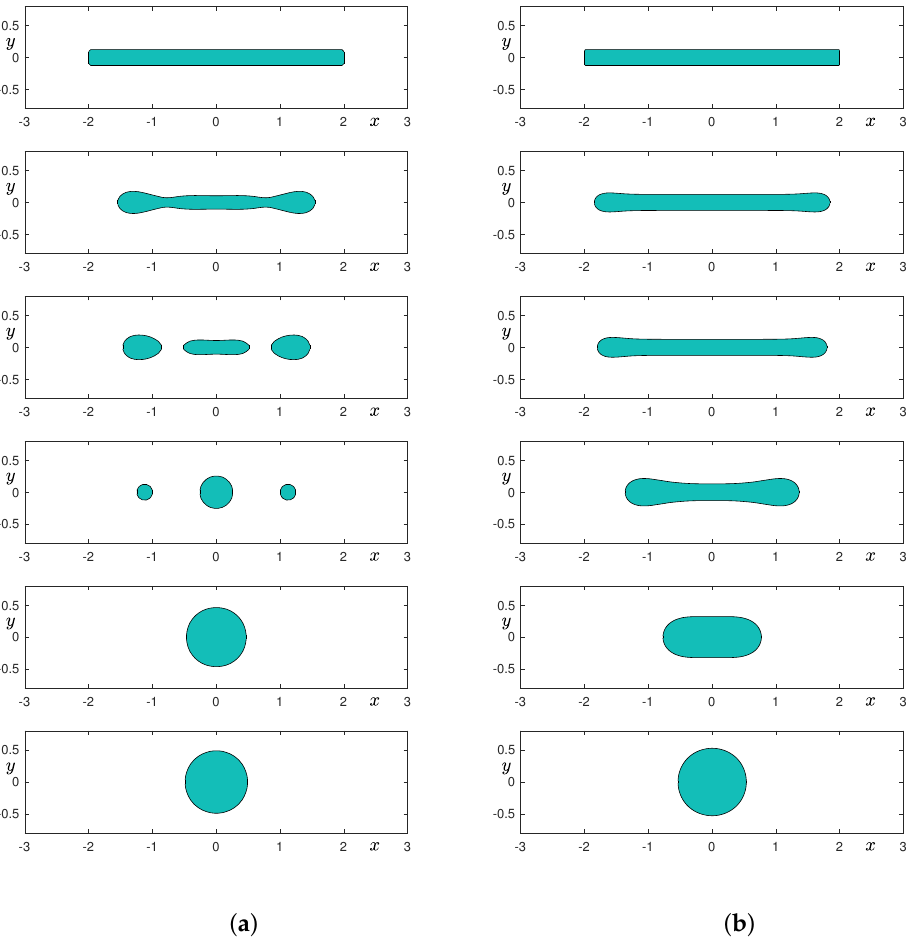
Figure 8. Temporal evolution of a thin rectangular shape without fluid flow: ( a ) 96 × 32 grid and ( b ) 192 × 64 grid. From top to bottom, times are at t = 0, 0.3, 0.4, 2, 6.4, and